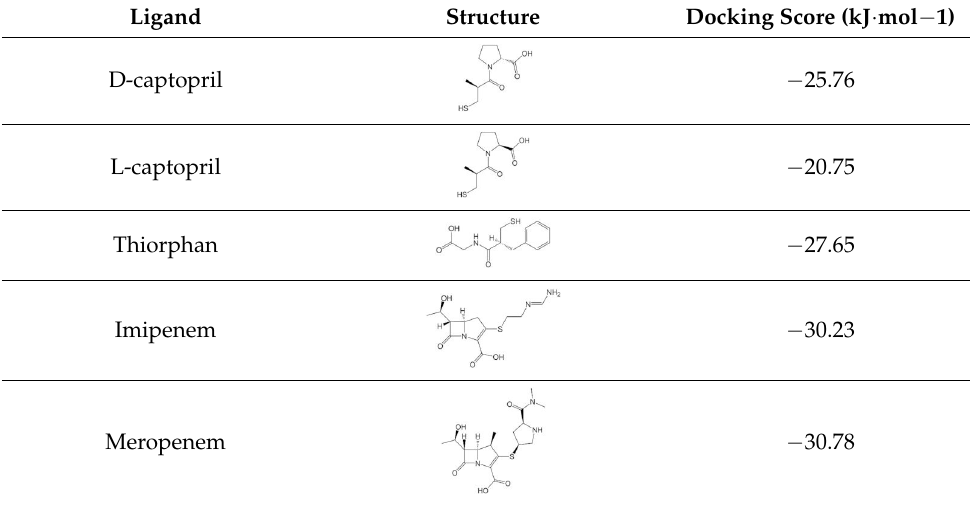
Table 2. Docking score of ligands with NDM-1 protein (PDB ID: 5ZJ2).